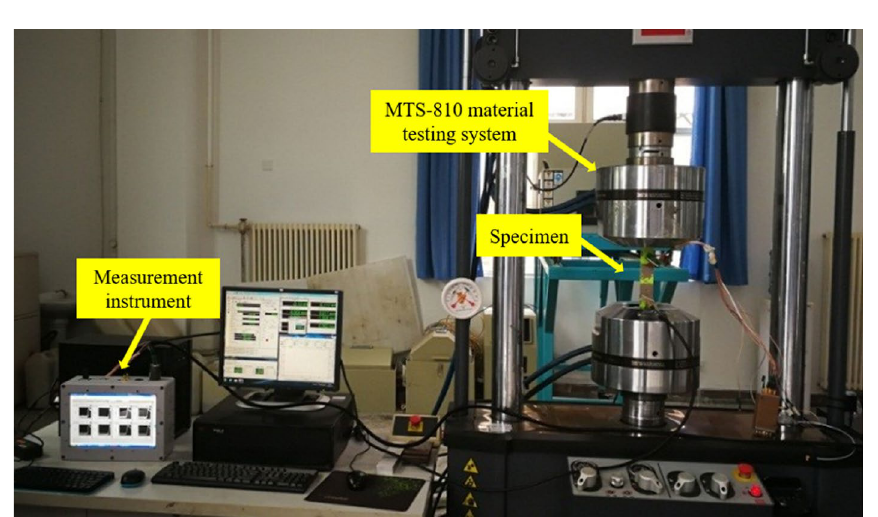
Figure 15. Structural fatigue crack monitoring